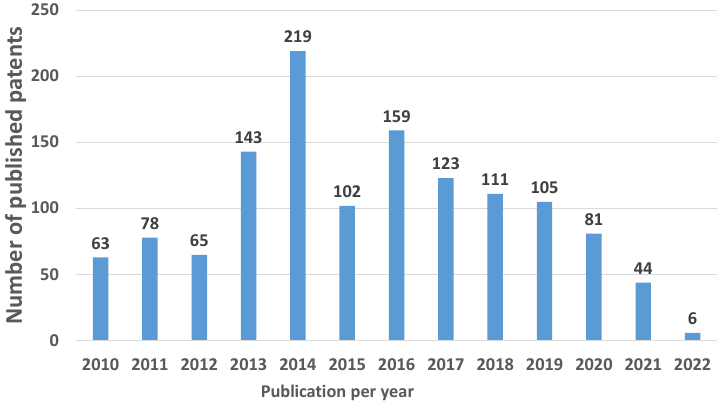
Figure 5. Annual number of published patents between 2010 and 2022. Annual average of patents published from 2010 to 2022 was 108. Therefore, monitoring number of patents issued in the period 2022–2030 will give insight into the technological progress in an ORC through solar collection systems.